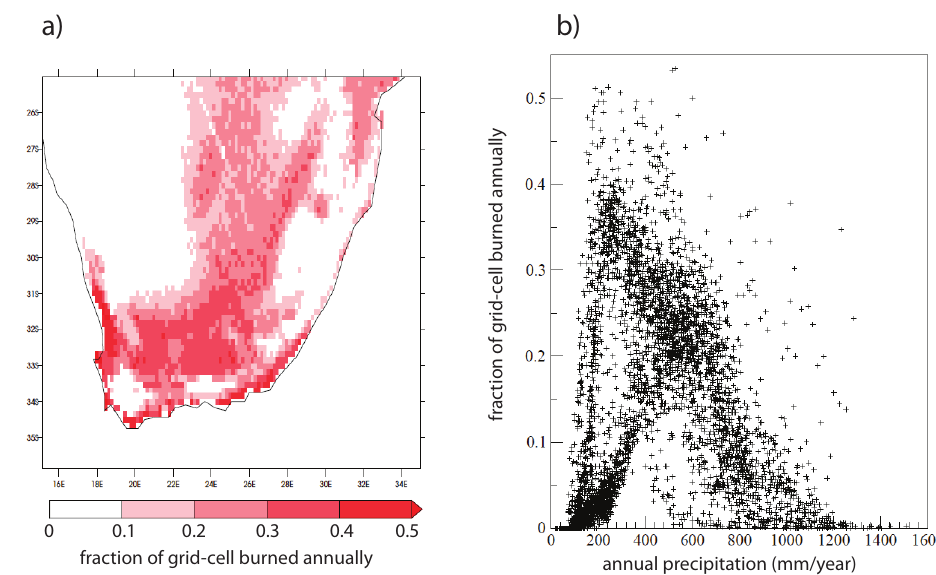
Figure 6. Present-day simulation of fire activity over southern Africa with LPJ-LMfire. (a) Fraction of a grid cell burned annually. (a) Annual fraction of a grid cell burned vs. total annual precipitation on the same grid cell (mmyr − 1